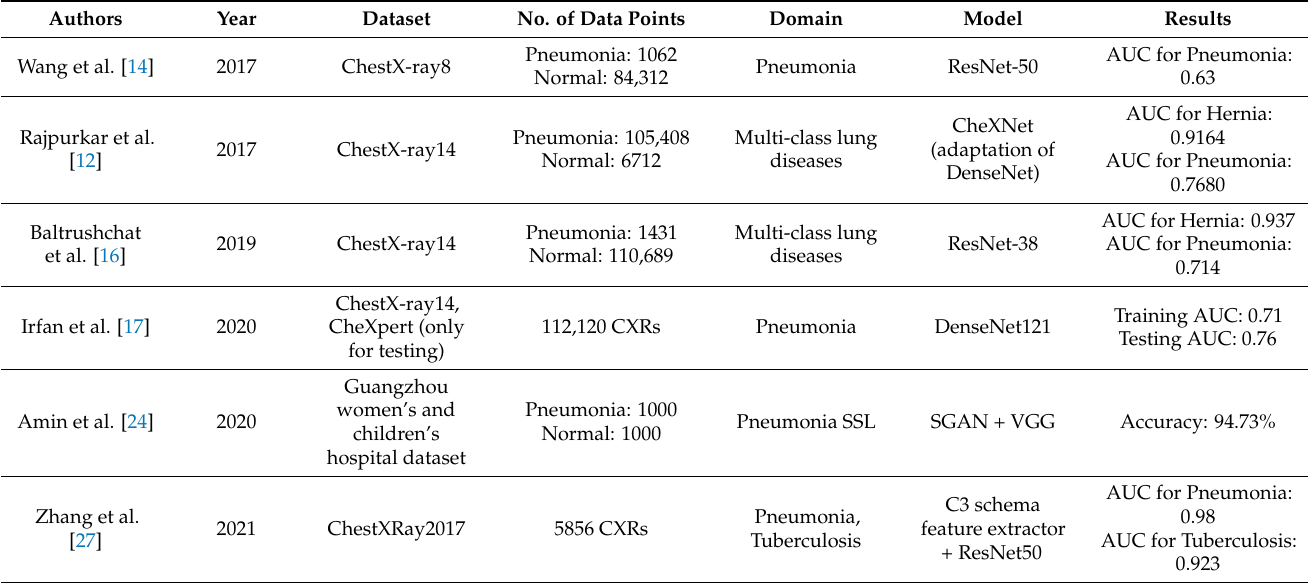
Table 1. Summary of work using deep learning for Pneumonia classification through CXRs.